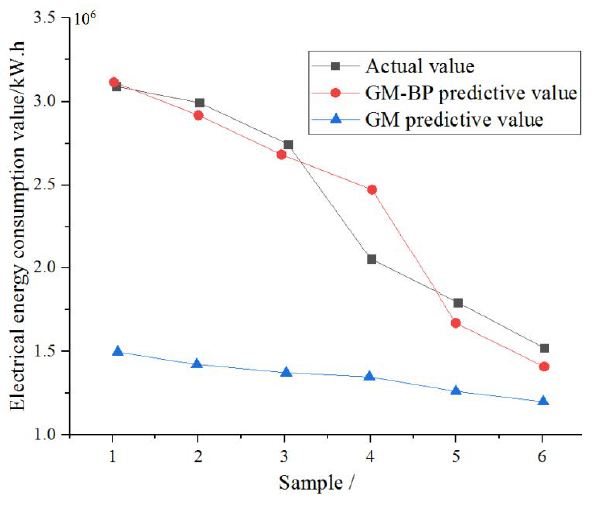
Fig. 1 Comparison of actual and forecasted values of each